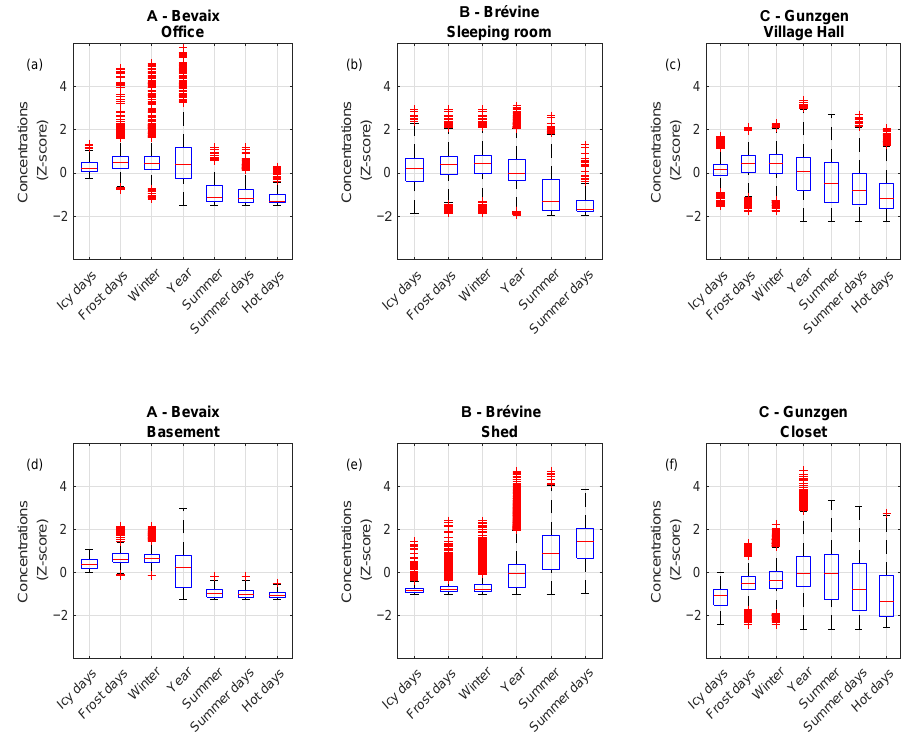
Figure 2. Box-plots synthesizing the impacts of outdoor air temperature on a yearly basis, summer and winter seasons, as well as for temperature thresholds on IRC at Bevaix ( a , d ), La Brévine ( b , e ), and Gunzgen ( c , f ). Occupied spaces are shown in ( a – c ) and unoccupied spaces in ( d – f ). Results for unoccupied indoor spaces differed at each study site. In Bevaix, results were similar to occupied spaces. However, cellar window were open during the whole summer period. In winter, IRC was similar to the office ones, albeit with less “spread” high values. La Brévine’s case study was unexpected, as opposed to other unoccupied space results. Shed IRC was higher during the summer than in the winter. It is worth noting that this shed is an uninsulated room—the floor is a wood parquet over a natural and permeable